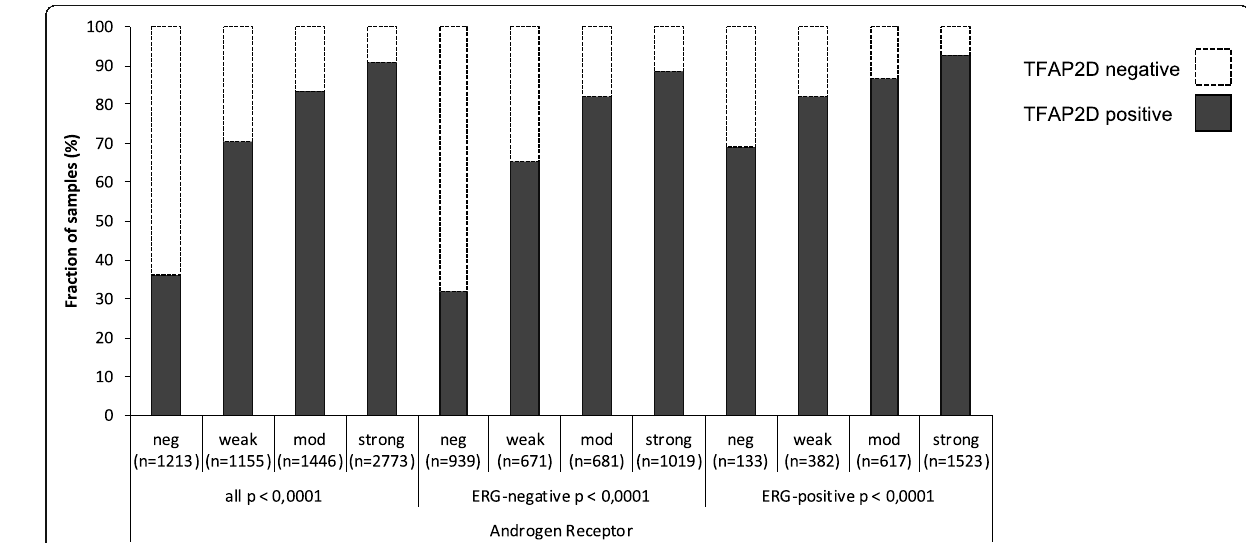
Fig. 5 Association between positive TFAP2D immunostaining and androgen receptor (AR) status in all cancers, ERG negative and ERG positive